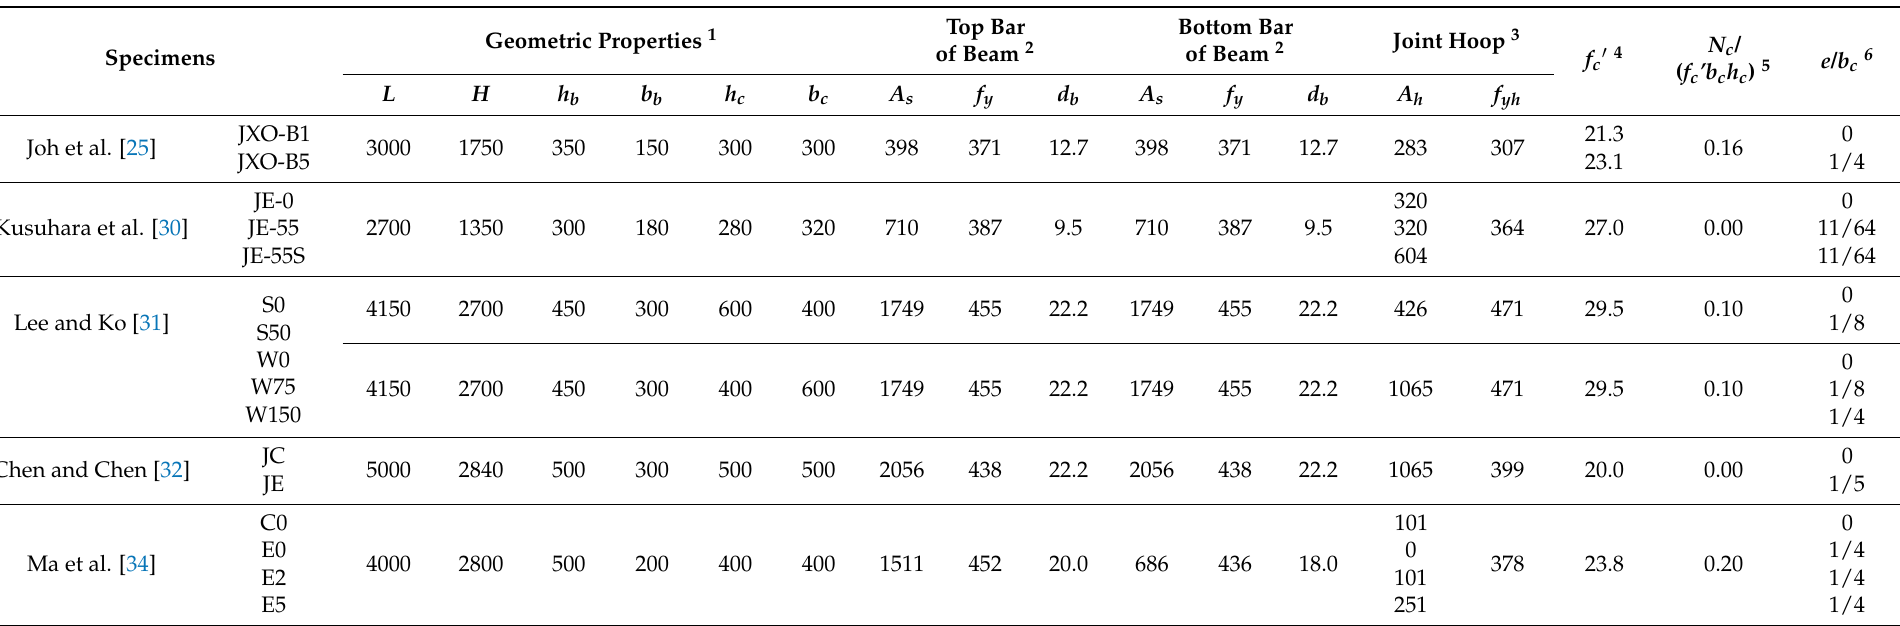
Table 2. Test parameters of existing beam–column joint test